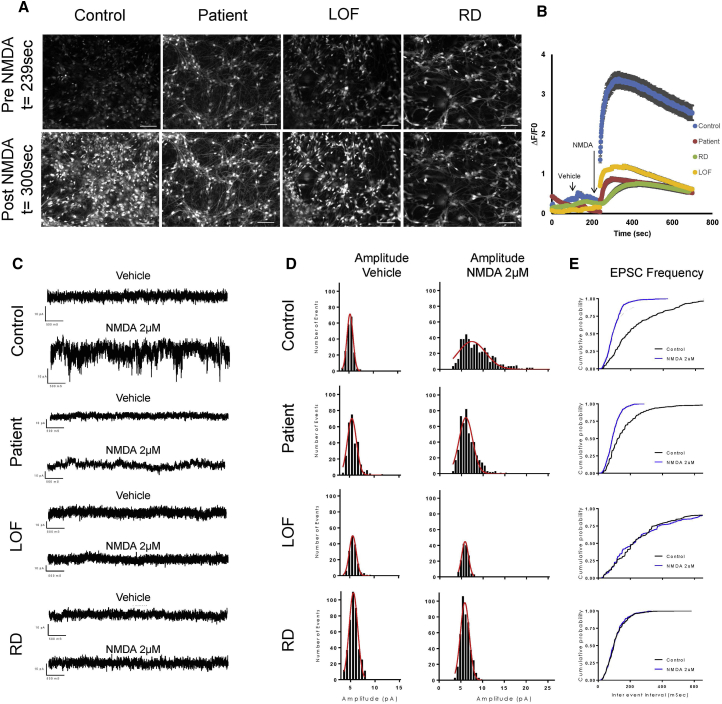
Forebrain Neurons with Genetic Deficiency in GRIN2B Show Impaired Responses to NMDA(A) Stills of D21 control, patient, RD, and LOF forebrain neurons incubated with the Fluo4 calcium indicator before and after application of NMDA. Stills obtained from Video S3. Application of NMDA to D21 Control Neurons, Related to Figure 6, Video S4. Application of NMDA to D21 Patient Neurons, Related to Figure 6, Video S5. Application of NMDA to D21 RD Neurons, Related to Figure 6, Video S6. Application of NMDA to D21 LOF Neurons, Related to Figure 6. Scale bars represent 40 μm.(B) Intensity of fluorescent signal detected in D21 control, patient, RD, and LOF forebrain neurons following application of NMDA and vehicle, as shown in Video S3. Application of NMDA to D21 Control Neurons, Related to Figure 6, Video S4. Application of NMDA to D21 Patient Neurons, Related to Figure 6, Video S5. Application of NMDA to D21 RD Neurons, Related to Figure 6, Video S6. Application of NMDA to D21 LOF Neurons, Related to Figure 6. Error bars denote SEM; n ≥ 58 cells imaged from a well containing each cell line.(C) Frequency of excitatory postsynaptic currents (EPSCs) in control, patient, RD, and LOF neurons after application of vehicle and 2 μM NMDA. Neurons measured between D5 and D9 differentiation time point.(D) Amplitude histogram distribution of EPSCs after application of vehicle or NMDA as described in (C). Amplitude distribution was fitted using a Gaussian fit.(E) Frequency of EPSCs after application of vehicle or 2 μM NMDA as described in (C).See also Figure S5 and Video S3. Application of NMDA to D21 Control Neurons, Related to Figure 6, Video S4. Application of NMDA to D21 Patient Neurons, Related to Figure 6, Video S5. Application of NMDA to D21 RD Neurons, Related to Figure 6, Video S6. Application of NMDA to D21 LOF Neurons, Related to Figure 6.